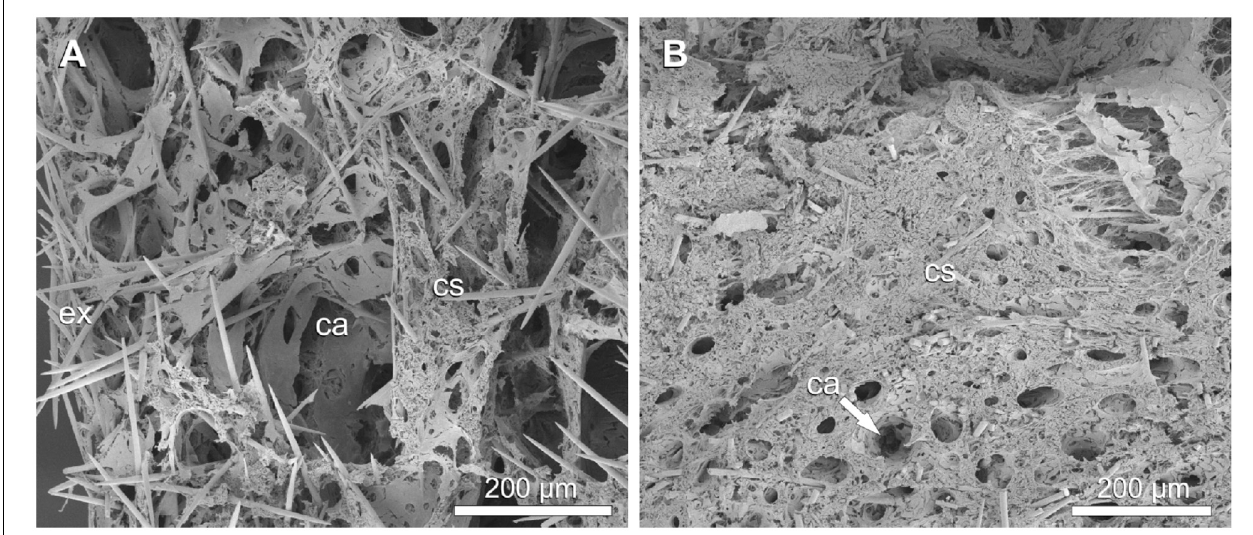
FIGURE 6 | Halichondria panicea , SEM, cryofracture. Internal morphology of single-osculum explants. (A) Expanded (untreated) explant, choanosome with several larger and smaller canals (ca). (B) Contracted explant (after exposure to 1 mM GABA), choanosome mostly with minor canals (ca). Legend: ca: canal, cs: choanosome, ex: exopinacoderm.